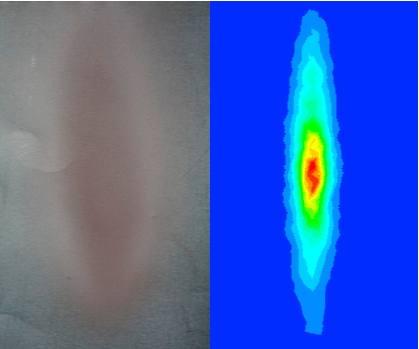
Figure 16. Planar tilted spraying: comparison of experimental and simulated coating film.